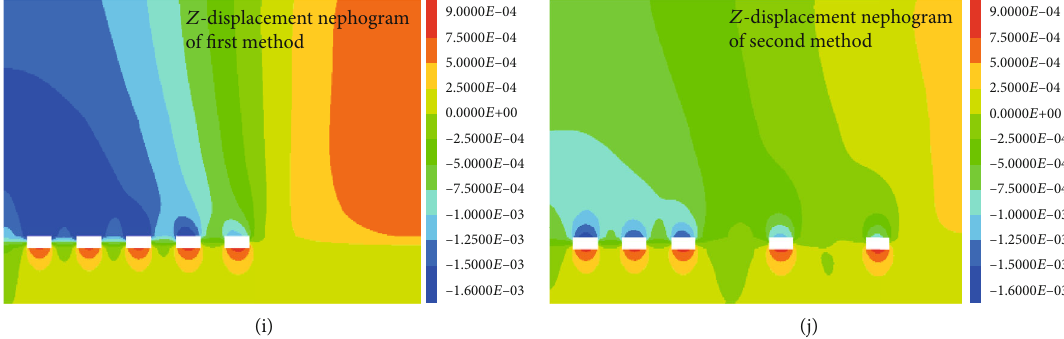
Figure 5: Stress nephogram and displacement nephogram of two methods. (a) Vertical stress nephogram of the fi rst borehole. (b) Displacement nephogram of the fi rst borehole. (c) Vertical stress nephogram of the second borehole. (d) Vertical stress nephogram of the second borehole. (e) Vertical stress nephogram of the third borehole. (f) Vertical stress nephogram of the third borehole. (g) Vertical stress nephogram of the third borehole. (h) Vertical stress nephogram of the third borehole. (i) Displacement nephogram of the fi fth borehole. (j) Displacement nephogram of the fi fth borehole.